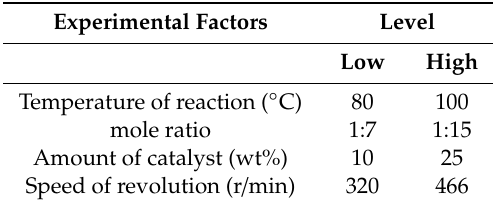
Table 1. Experimental factors and levels of orthogonal experiment.